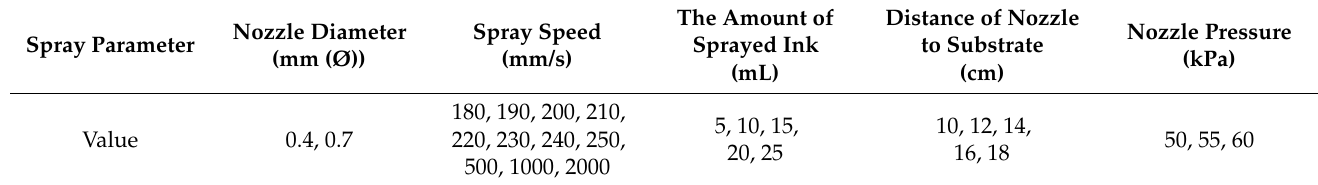
Table 1. Five parameters of the spray